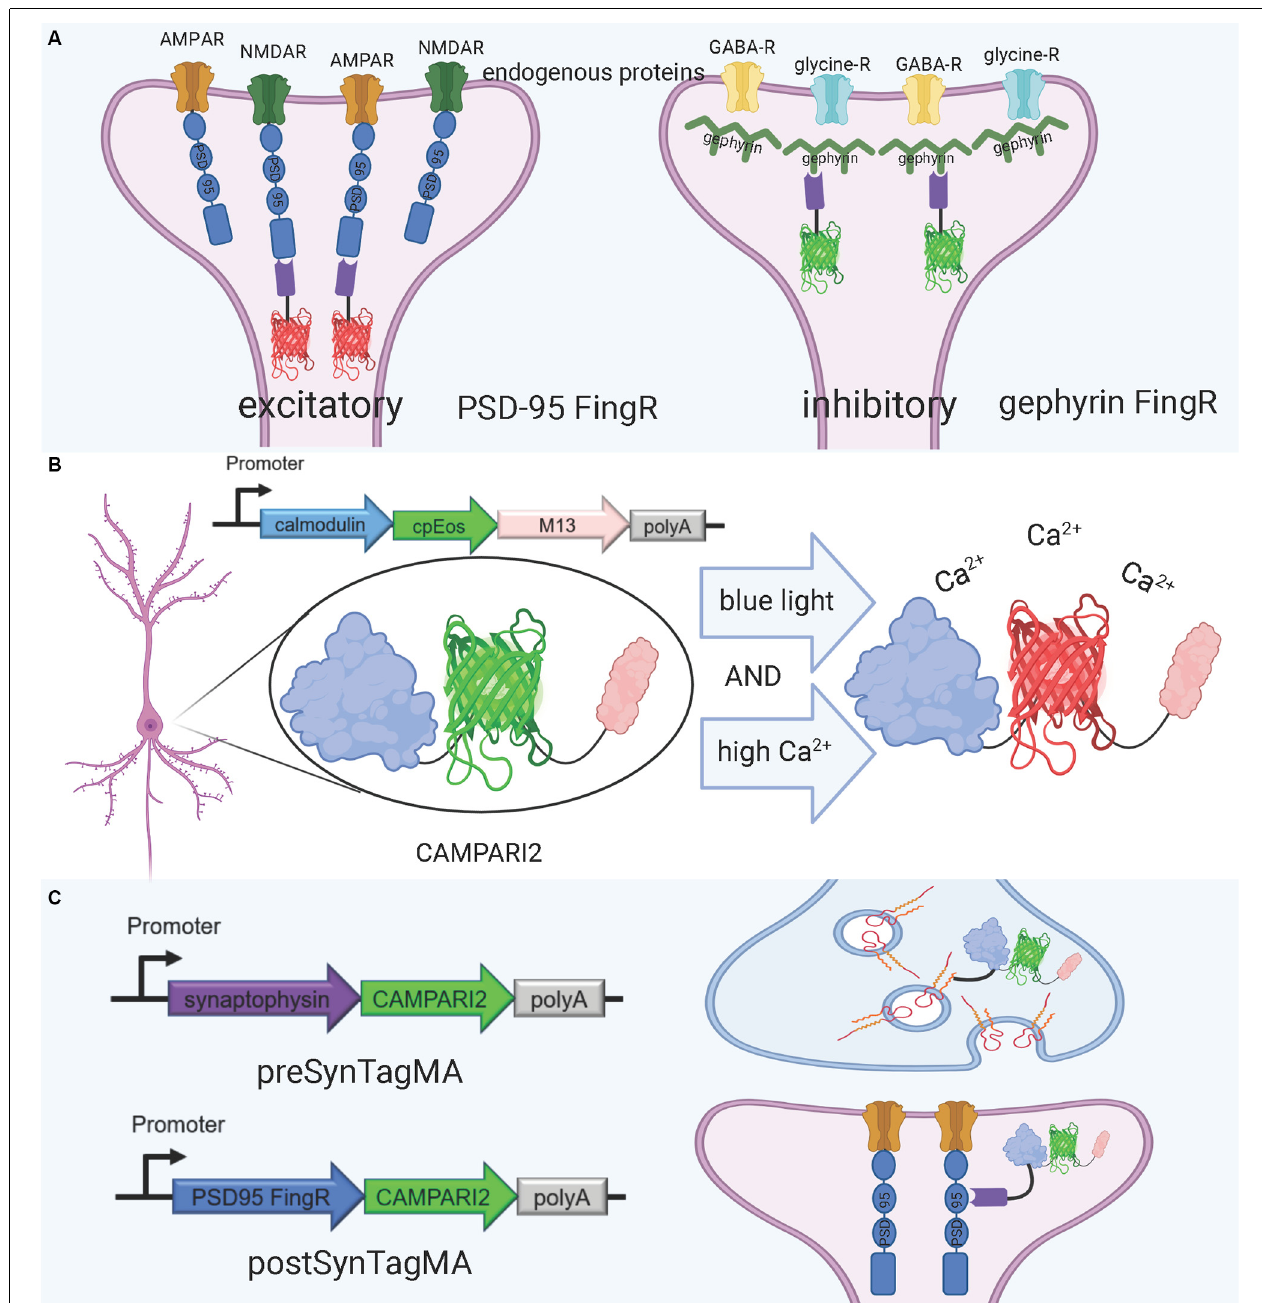
FIGURE 4 | FingRs and related tools. (A) Schematic diagram of FingRs for post-synaptic labeling of excitatory and inhibitory synapses, using endogenous PSD-95 and gephyrin, respectively. (B) Schematic diagram of CAMPARI2, a genetically encoded calcium indicator, which changes fluorescent wavelength in response to combined blue light and high calcium ion levels. CAMPARI2 forms the fluorescent component of SynTagMA. (C) Schematic diagram of pre-SynTagMA, which marks synaptophysin, and post-SynTagMA, which marks endogenous PSD-95 with the aid of a PSD-95-specific FingR. Created with